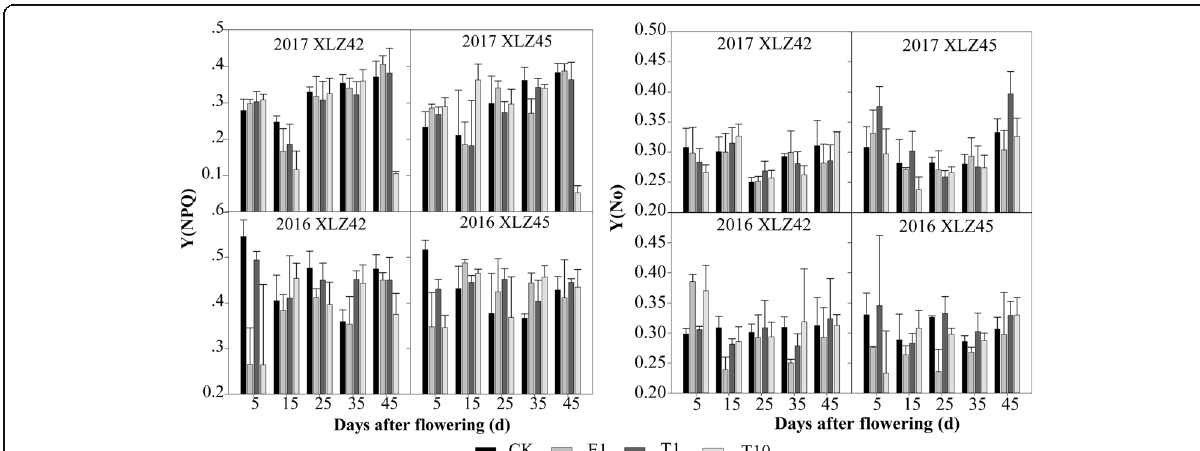
Fig. 7 Quantum yield of light-induced (Y (NPQ)) and non-light induced(Y (NO)) non-photochemical fluorescence quenching of cotton varieties (XLZ42 and XLZ45) at different days since flowering in various treatment groups: 1 and 10 days before the first irrigation (T1, T10, respectively) and 1 day before the second irrigation (E1) after seedling emergence, during 2016 – 2017. The control group (CK) had film mulching throughout the growth stages. Bars are means ± standard deviation (n =